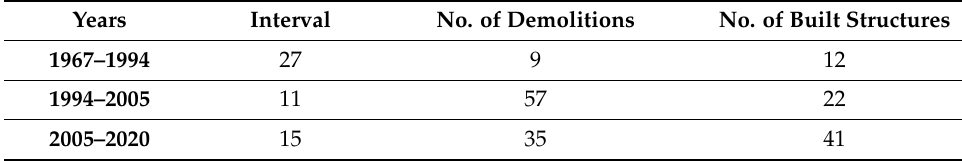
Table 1. Summary of demolitions and new buildings